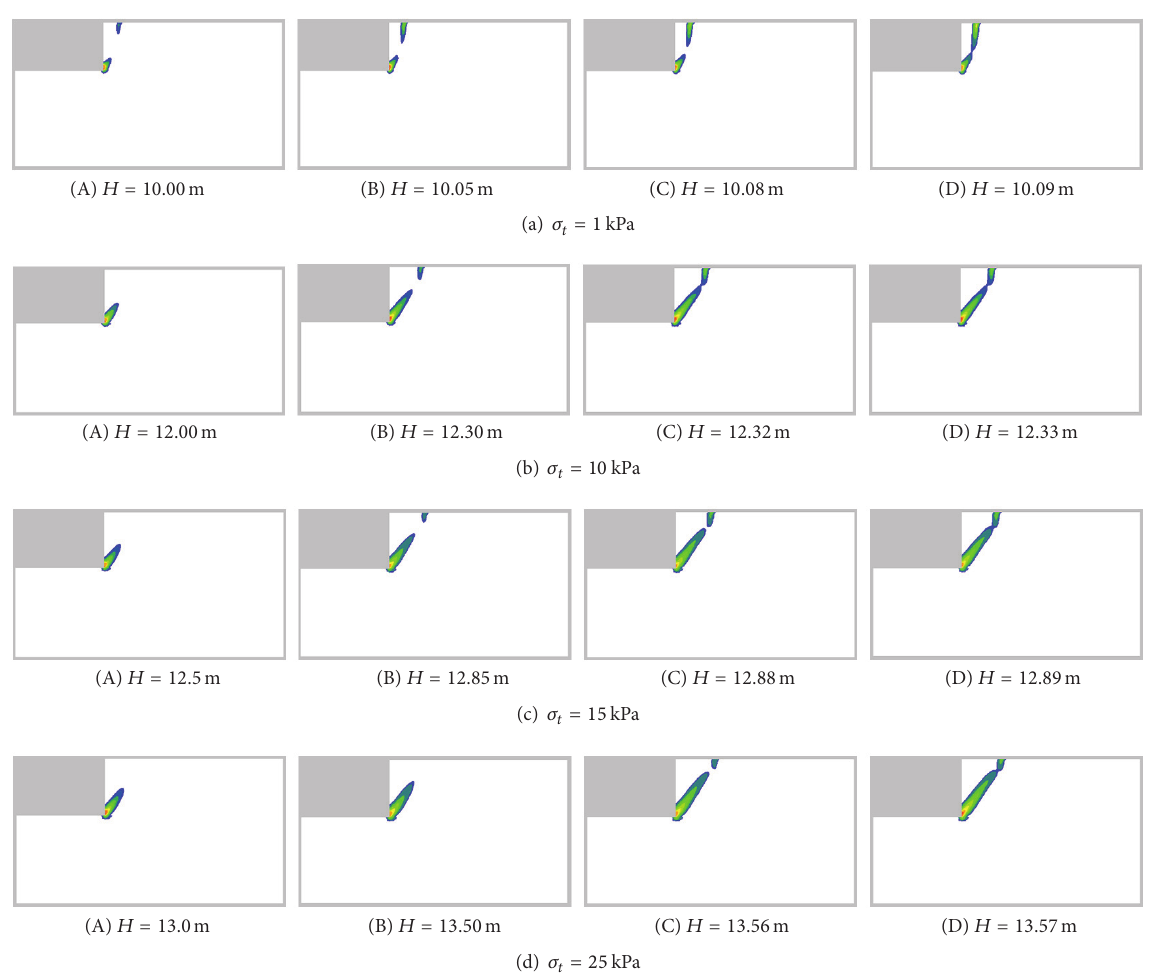
Figure 5: Contour of ultimate shear stain of slope slip at different tension strength (unit: m).